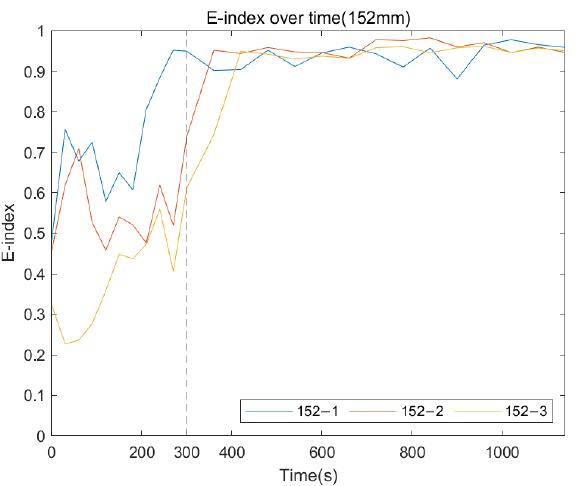
Figure 14. E ‐ index development as the function of cure time for 152 mm. Figure 14. E-index development as the function of cure time for 152